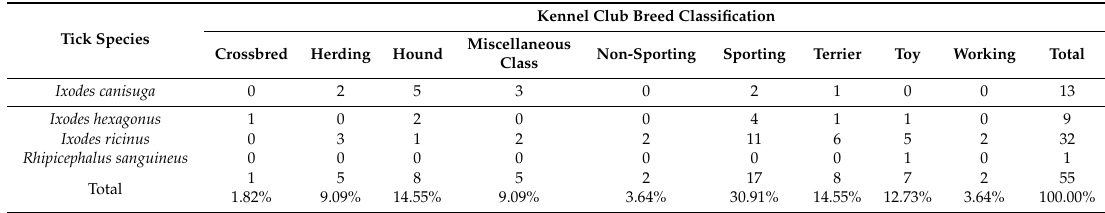
Table 3. Ticks detected on various dog breeds.